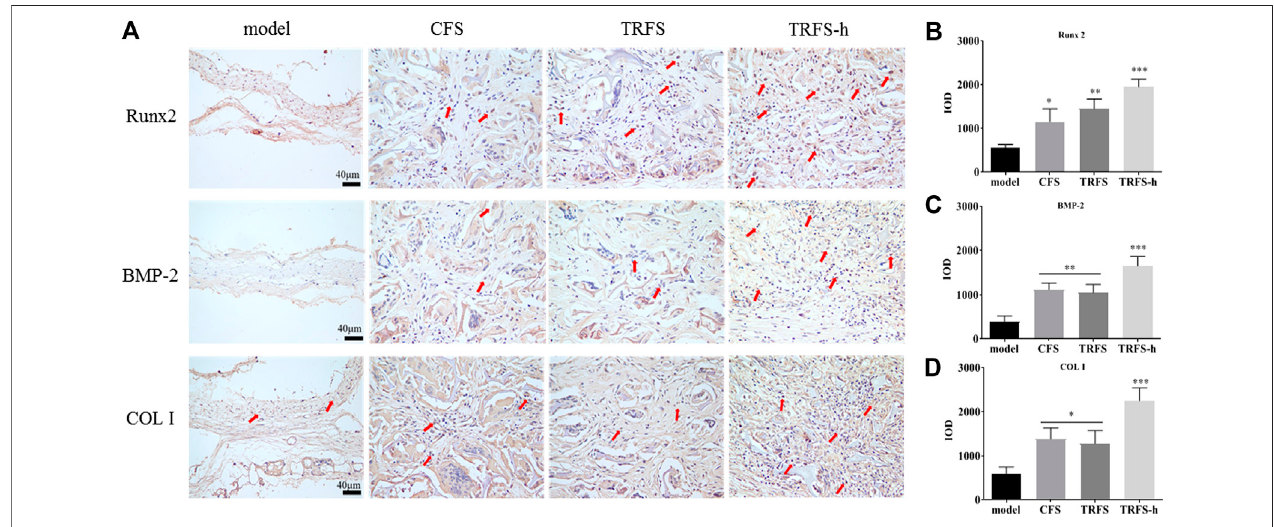
FIGURE 4 | Osteogenesis-associated protein immunohistochemical staining was performed in skull tissue sections at 12 weeks post-surgery (A) Immunohistochemical staining of osteogenesis-associated proteins Runx2, BMP-2, and COL I. Red arrows indicate positive cells (B) Runx2 positive statistics (C) BMP-2 positive statistics (D) COL I positive statistics ( n (cid:1) 3, * p < 0.05, ** p < 0.01, *** p < 0.001 vs